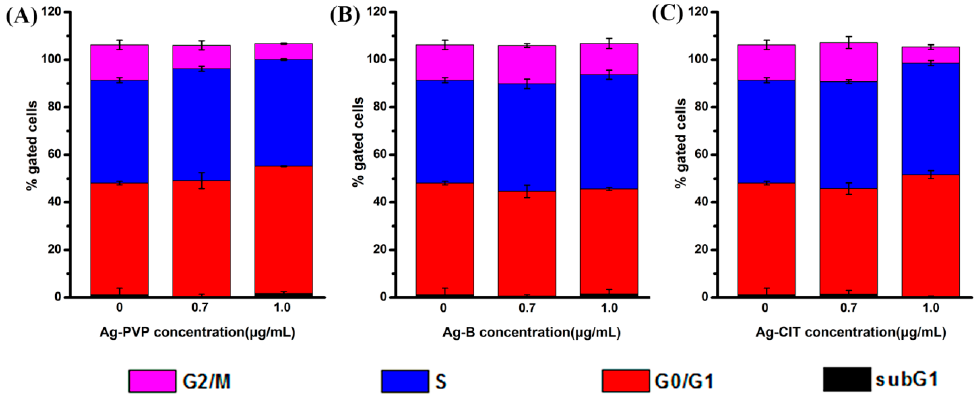
Figure 6. Cell cycle distribution of Caco-2 cells after exposed to three Ag NPs for 24 h. ( A ) Ag-PVP NPs; ( B ) Ag-B NPs; ( C ) Ag-CIT NPs. All data are represented as the mean ± SD ( n = 3).